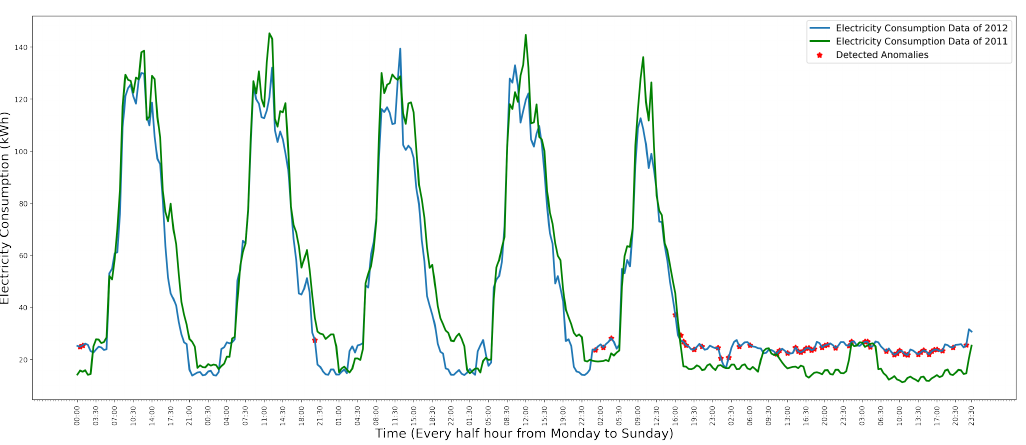
Figure 8. Anomaly detection in weekly data by the Gaussian kernel distribution model. Adapted from [8]. In Figure 8, the green line is the data of the year 2011, which is used to estimate the distribution. The blue line is the data of the year 2012. The red “*” is the detected anomalies in the data of the year 2012. Comparing the data of the year 2011 and 2012, the model has detected all the anomalies in the Monday, Friday, Saturday and Sunday’s data. However, the Gaussian kernel distribution model also comes with a low precision, which is shown in Figure